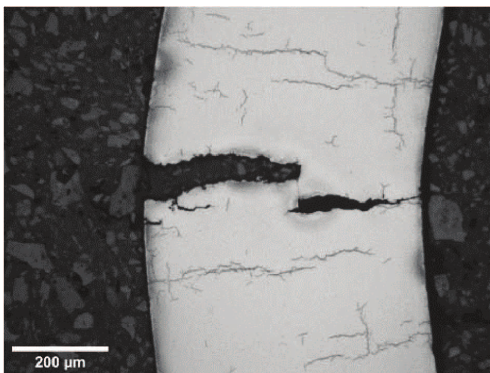
Fig. 2. Brittle failure of a pre-hydrided unirradiated ZIRLO(R) cladding sample with radial hydrides subjected to a ring compression